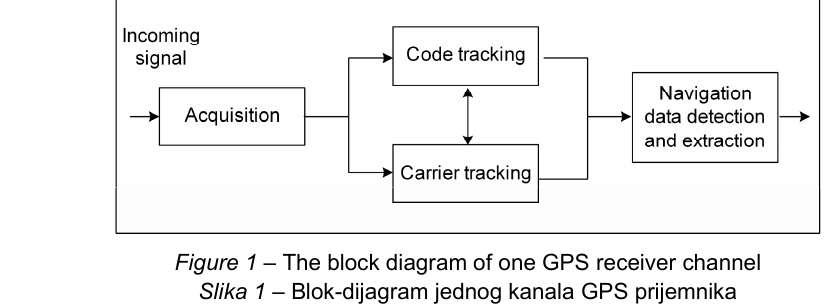
Figure 1 – The block diagram of one GPS receiver channel Рис . 1 – Блок диаграмм одного канала GPS приемника